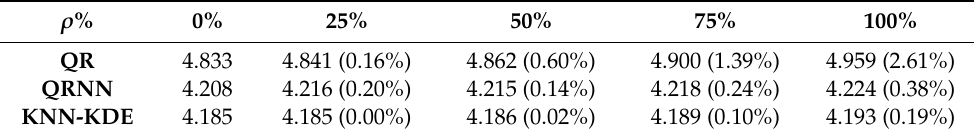
Table 4. QS values of three probabilistic forecasting models under false data attacks on input variable